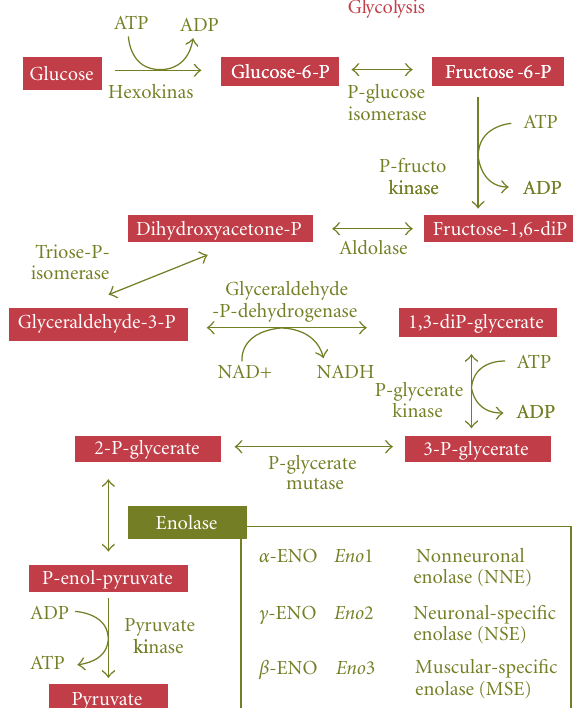
Figure 1: Summary of glycolytic metabolic pathway. Metabolic chain reactions of glycolysis, the central pathway for the catabolism of carbohydrates that takes place in the cytoplasm of almost all prokaryotic and eukaryotic cells. The insert shows di ff erent enolase isoenzymes in vertebrates.